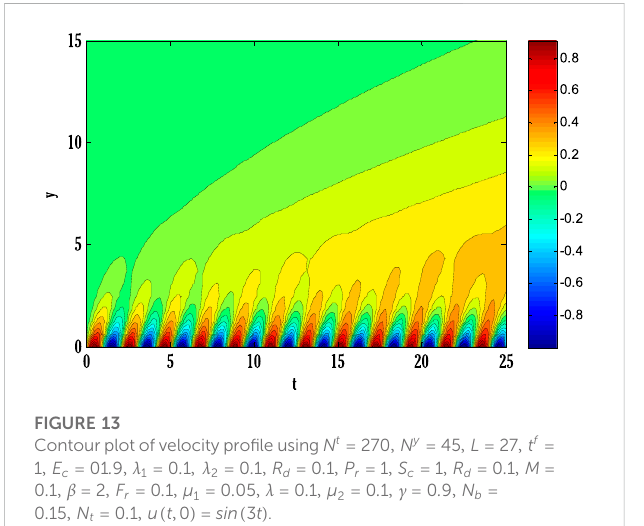
FIGURE 15 Contour plot of concentration pro fi le using N t (cid:2) 270 , N y (cid:2) 45 , L (cid:2) 27 , t f (cid:2) 1 , E c (cid:2) 01 . 9 , λ 1 (cid:2) 0 . 1 , λ 2 (cid:2) 0 . 1 , R d (cid:2) 0 . 1 , P r (cid:2) 1 , S c (cid:2) 1 , R d (cid:2) 0 . 1 , M (cid:2) 0 . 1 , β (cid:2) 2 , F r (cid:2) 0 . 1 , μ 1 (cid:2) 0 . 05 , λ (cid:2) 0 . 1 , μ 2 (cid:2) 0 . 1 , γ (cid:2) 0 . 9 , N b